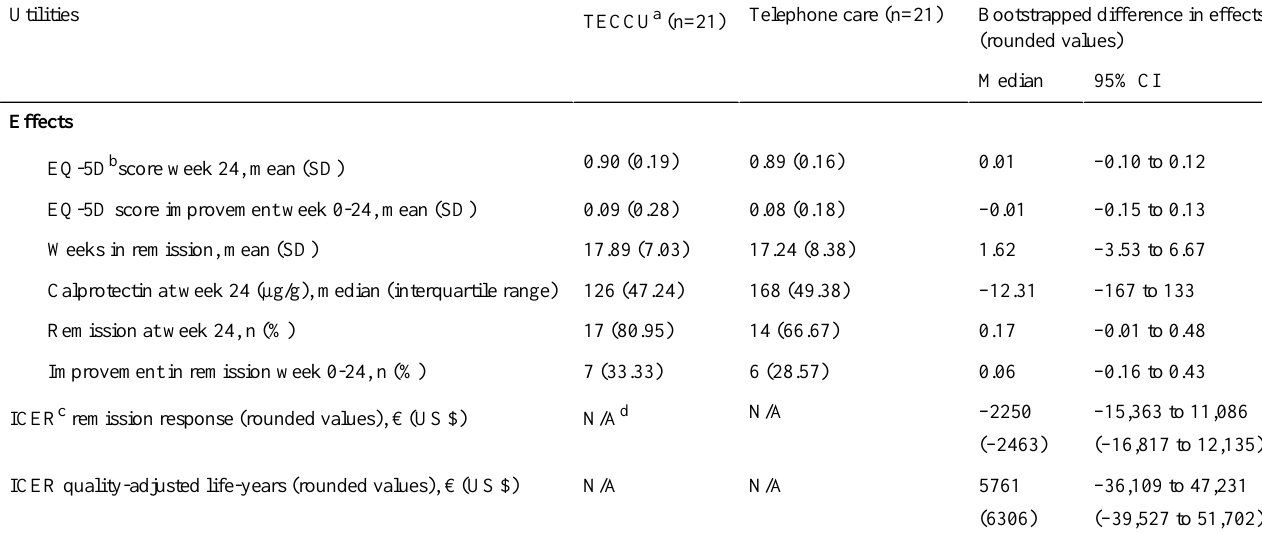
Table 6. Utilities per patient in the group receiving remote monitoring (G_TECCU) vs nurse-assisted telephone care (G_NT).